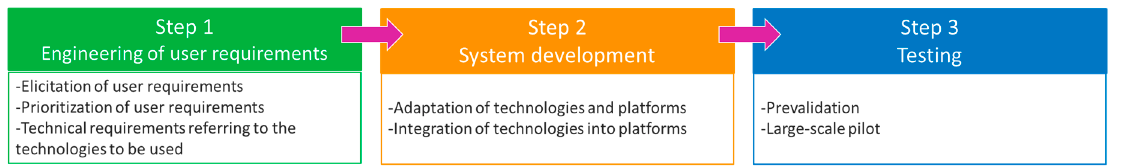
Figure 2. Work sequence within the Pharaon Murcia pilot.